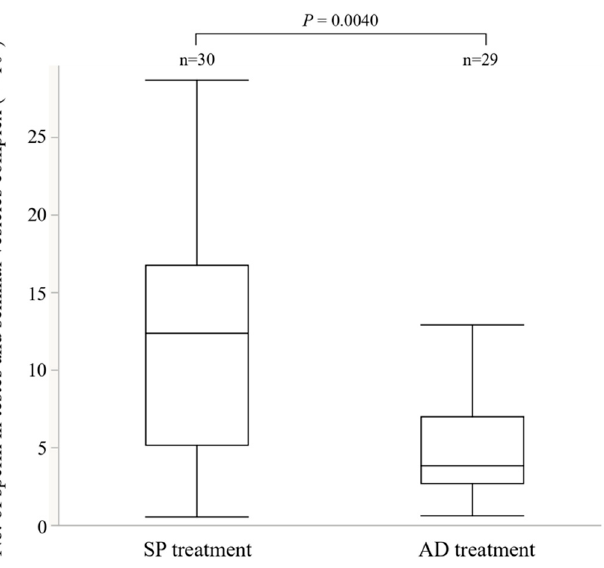
Figure 3. Comparison of the number of sperm in the testes-seminal vesicles complex of different male treatments. Boxplots represent medians (thick lines), the first and third quartile ranges (box perimeters), minimum and maximum (whiskers). The diet of the larvae significantly affected the number of sperm in the testes -seminal vesicles complex (GLM, larval diet; χ 2 = 8.2629, p = 0.0040).